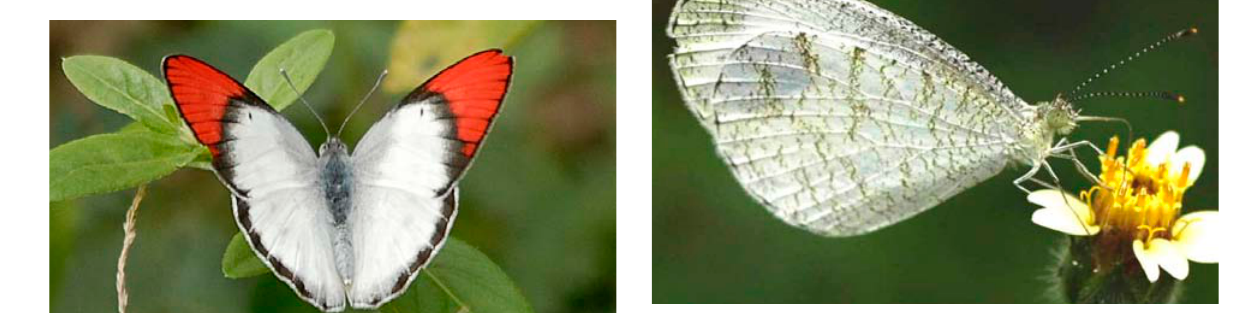
Image 7. Psyche Leptosia nina